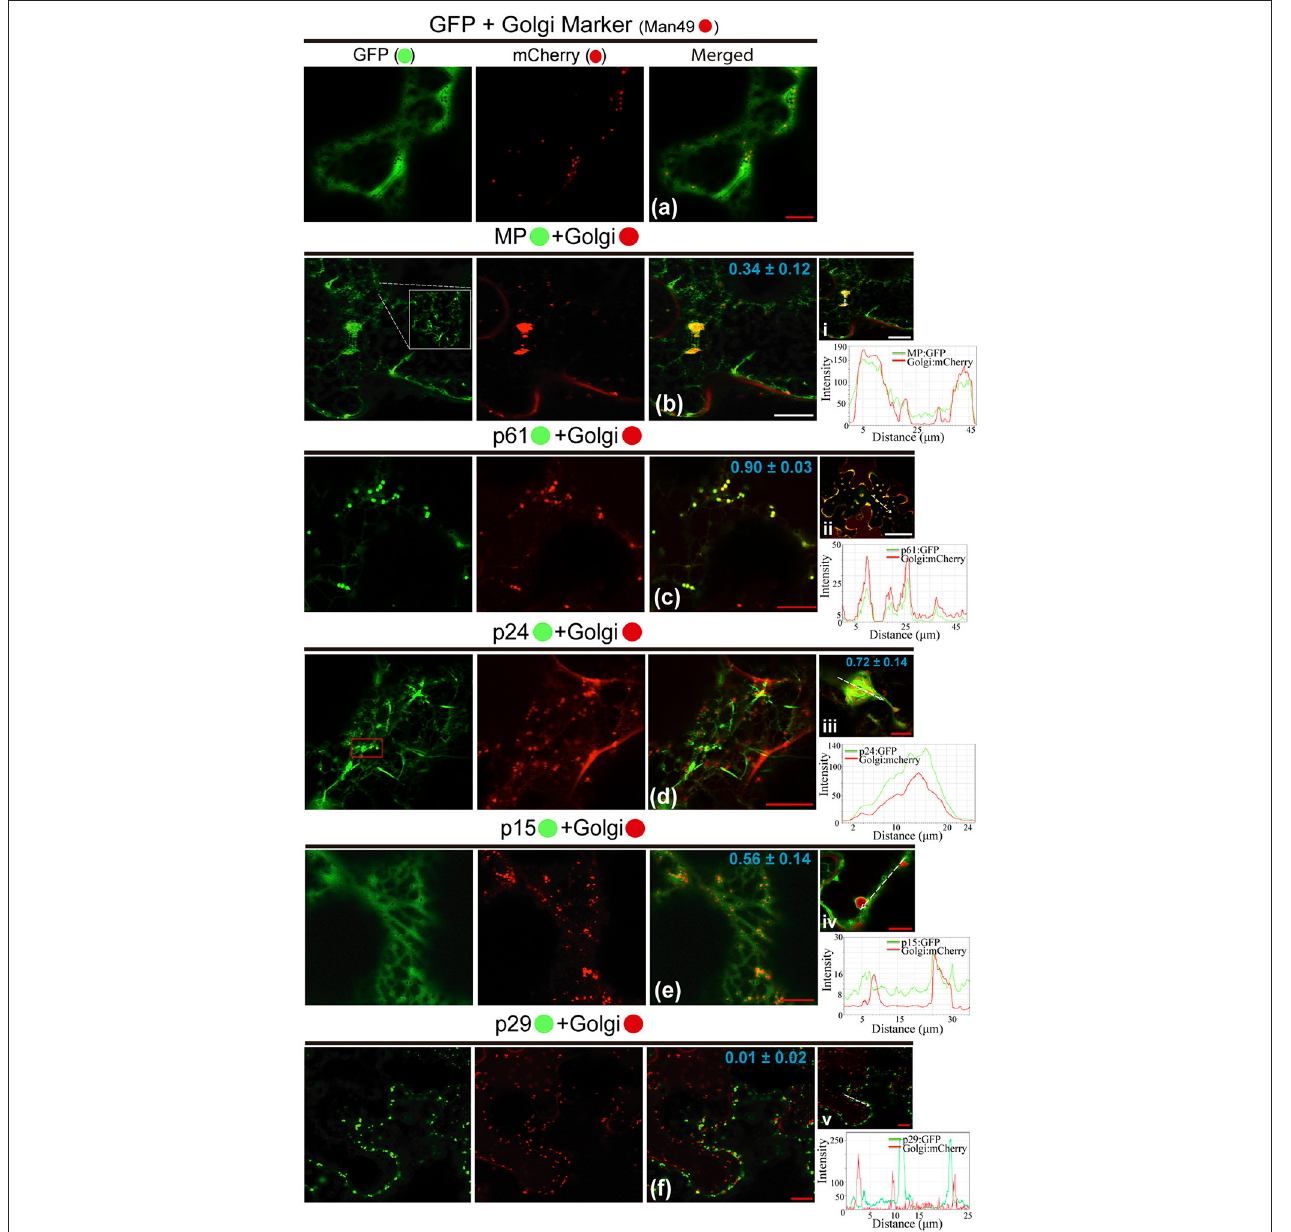
FIGURE 4 | All CiLV-C proteins (except p29) co-localize with Golgi and remodel the distribution of the GC apparatus . The p29, p15, p61, MP, and p24 proteins fused at their C-termini with eGFP (•) were co-expressed with man49-(•)mCherry (Golgi marker) in epidermal cells of N. benthamiana . Fluorescence signals were captured 72h post-infiltration (except for p61, captured 24–36 hpi) with confocal microscope Leica SP8 model. The green (GFP), red (mCherry) channels, and merged images are shown in the figure. (a) Image exhibits unfused GFP expression in a diffuse signal evenly distributed in the cytoplasm with individualized GC circular structures also dispersed throughout the cytoplasm. (b) Merged image shows that MP:eGFP and Golgi co-localize, with MP:eGFP filaments intertwined the Golgi apparatus, forming pleomorphic agglomerates in the cytosol. White box in the GFP channel shows in more detail the MP filaments. (c) Co-localization of the p61:eGFP globular bodies with Golgi apparatus. (ii) The image shows the aggregates formed from association of the p61:eGFP and GC dispersed throughout the cytoplasm. (d) The p24:eGFP filaments and spherical structures (red box) are observed merged with Golgi apparatus. (iii) Curious cytopathic effect of the p24:eGFP expression, with a remodeling of Golgi apparatus in flattened circular aggregates, with the viral protein, in long parallel filaments covered the GC aggregates forming inclusions. (e) p15:eGFP co-localizes with GC, with the protein apparently associated with ER, which emerges on Golgi apparatus. (iv) Merged image exhibits changes in the GC distribution with the formation of circular Golgi aggregates internalized possibly by ER containing the p15:eGFP proteins diffused along the ER network. (f) No co-localization of the p29:eGFP punctate bodies with GC. The mean SD of PCC at the top of the merged image, and chart of fluorescence intensities further confirm the co-localization of the MP, p61, p24, and p15 with Golgi (merged pictures i–iv, respectively). Plot shows green and red fluorescence intensities, indicated by (CiLV-C-Proteins):GFP and Golgi:mCherry, in the selected region of interest (dotted arrows). Distance measurement starts from the base to the tip of the arrows (x axis). Red and white bars correspond to 10 and 50 µ m,